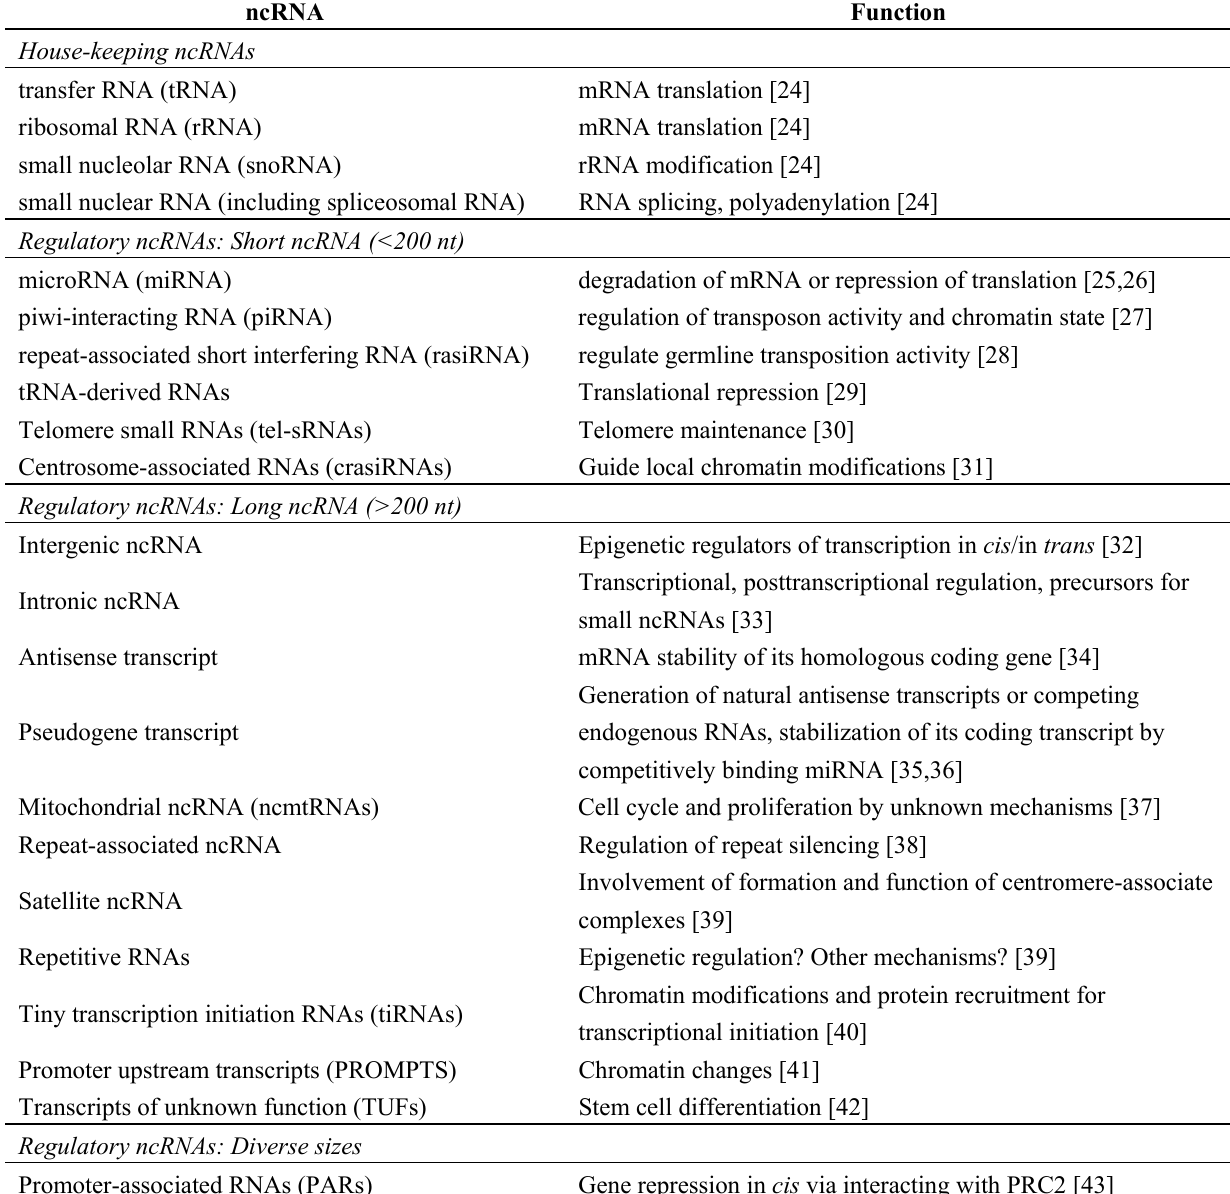
Table 1. Classification and functional roles of non-coding RNA (ncRNA) in